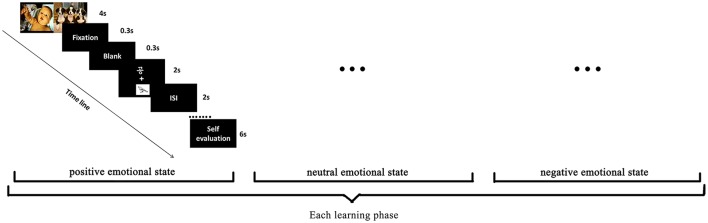
Learning procedure in each learning phase.